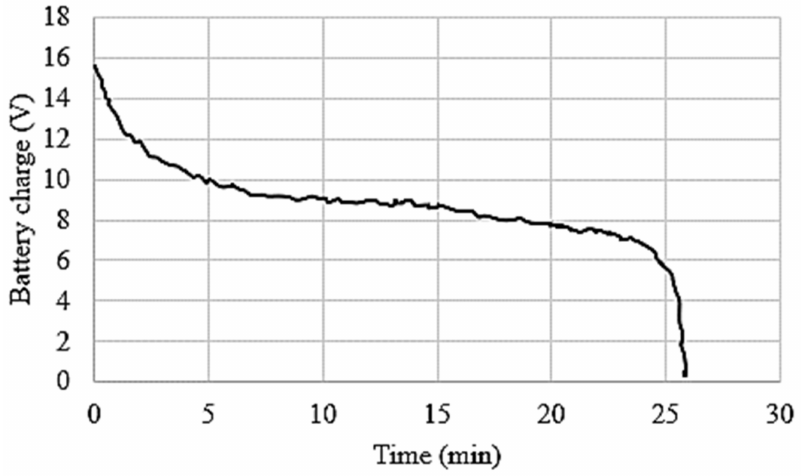
Figure 10. Endurance of